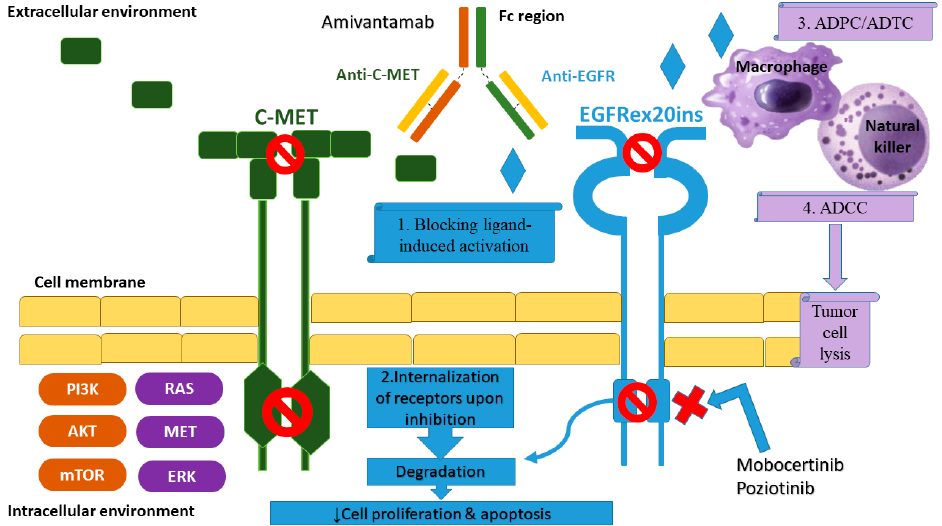
Figure 3. Mechanism of action of amivantamab in EGFR exon 20 insertions. Amivantamab is a human bispecific antibody, which is effective against EGFR with Exon 20 Insertion mutations. Additionally, amivantamab targets the C-MET membrane receptor, which mediates MET amplification, an emerging non-EGFR dependent mechanism of resistance. It yields a quadruple mechanism of action. First of all, it induces Fc independent downregulation of oncogenic signaling by means of downmodulation (1) and/or internalization of EGFR and C-MET membrane receptors and subsequent degradation that leads to apoptosis (2). Its immune-mediated activity is induced by macrophages-mediated ADCT or ADPC (3) as well as ADCC, which is primarily mediated by natural killers. Mobocertinib and poziotinib are additional novel agents with potential activity against NSCLC with EGFR exon 20 insertions. Mobocertinib is an irreversible TKI that selectively targets in-frame EGFRex20ins mutations and poziotinib is a pan-HER irreversible TKI. ADTC: Antibody–Drug Cellular Trogocytosis, ADPC: Antibody–Drug Cellular Phagocytosis, ADCC: Antibody–Drug Cytotoxicity.